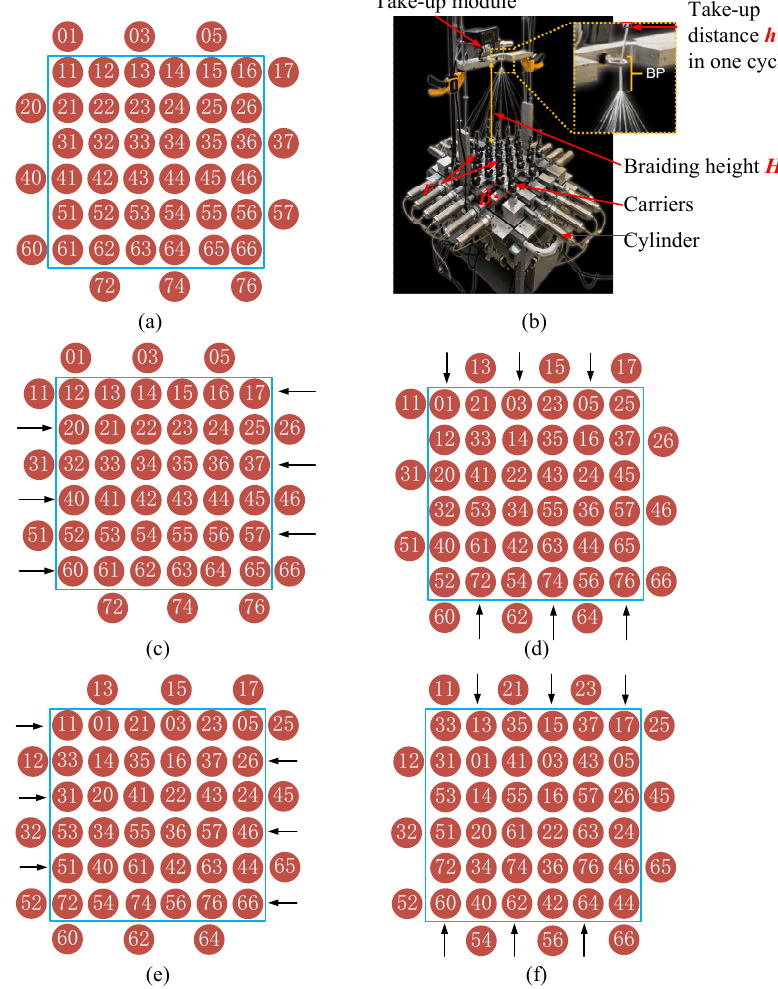
Figure 1. Schematic of the 3D four-directional braiding process: ( a ) the original arrangement, ( b ) the braiding machine [27]. Reprinted with permission from [27]. Copyright 2020, The Regenerative Engineering Society. ( c ) Step 1, ( d ) Step 2, ( e ) Step 3, and ( f ) Step 4.